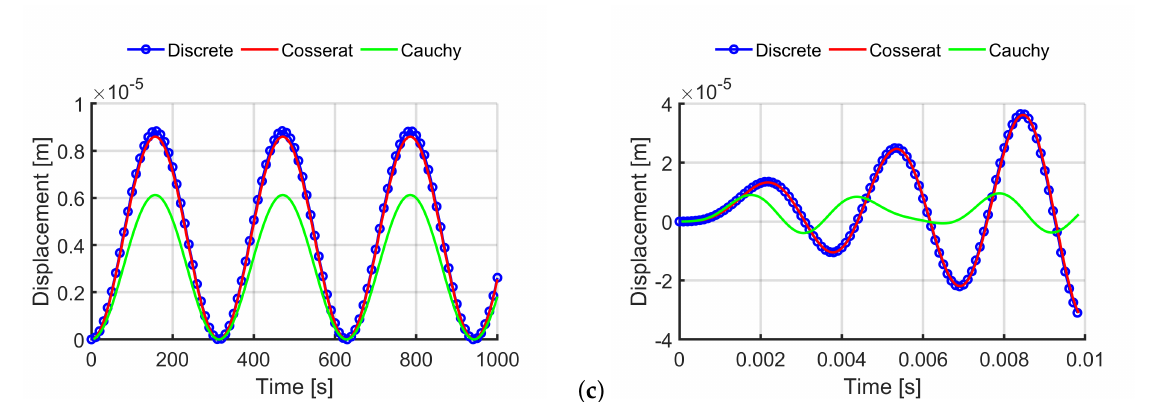
Figure 5. Time-history analysis for texture 2: horizontal displacements for the three texture scales ( a ) s = 1; ( b ) s = 0.5; ( c ) s = 0.25 (load case 1); ( d ) mechanical resonance for the scale s = 0.5 (load case